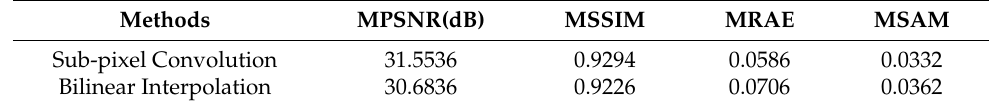
Figure 12. Training error of the model using sub-pixel convolution and bilinear interpolation. Table 4. Quantitative comparisons of using sub-pixel convolution and bilinear interpolation (the metric is the average of all test images).